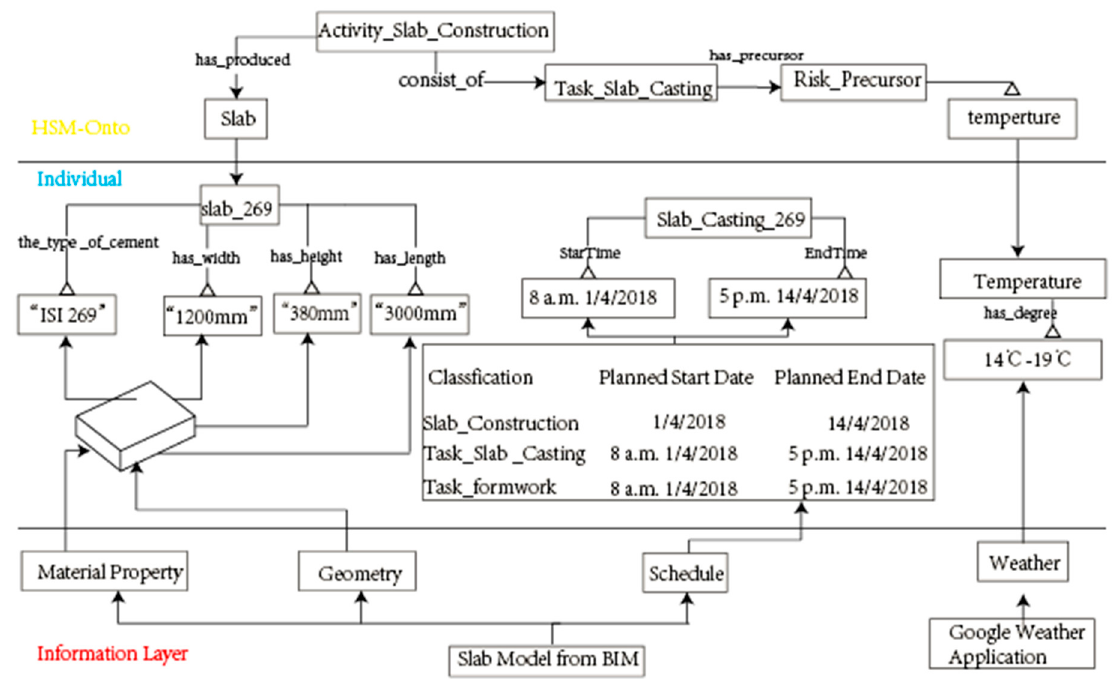
Figure 12. Ontology-based individual